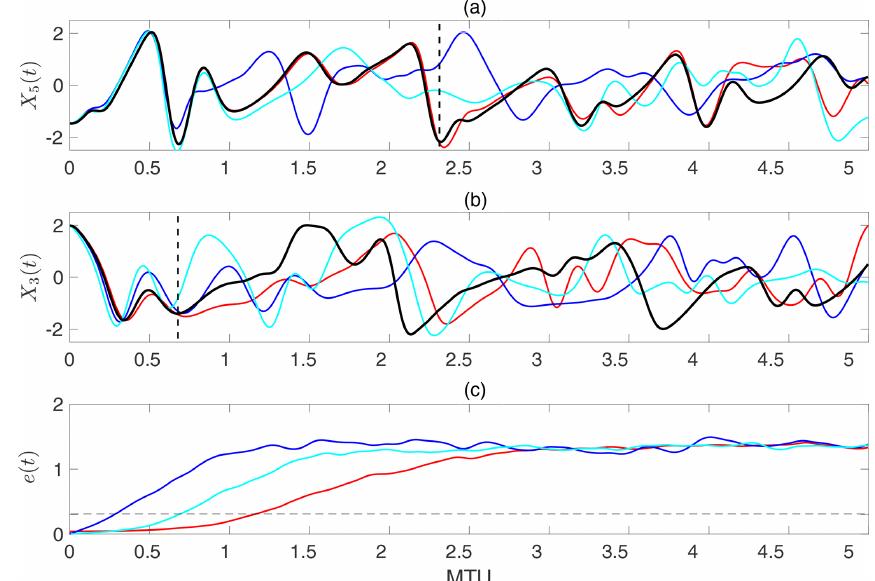
Figure 5. Comparison of the short-term forecasting skills among the three ML methods. The lines show truth (black), RC–ESN (red), ANN (blue), and RNN–LSTM (cyan). Panels (a) and (b) show examples (differing in initial condition) for which RC–ESN yields the longest and shortest prediction horizons, respectively. Vertical broken lines show the approximate prediction horizon of RC–ESN. Panel (c) shows the relative L 2 error averaged over 100 randomly chosen initial conditions e(t) ; see Eq. 8. The broken horizontal line marks e = 0 . 3. Time is in MTU, where 1MTU = 200 (cid:49)t ≈ 4 . 5 /λ max . Training size is N = 500000. ρ = 0 . 1 is used